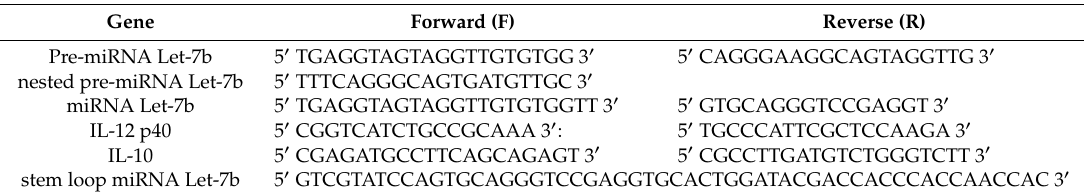
Table 1. List of